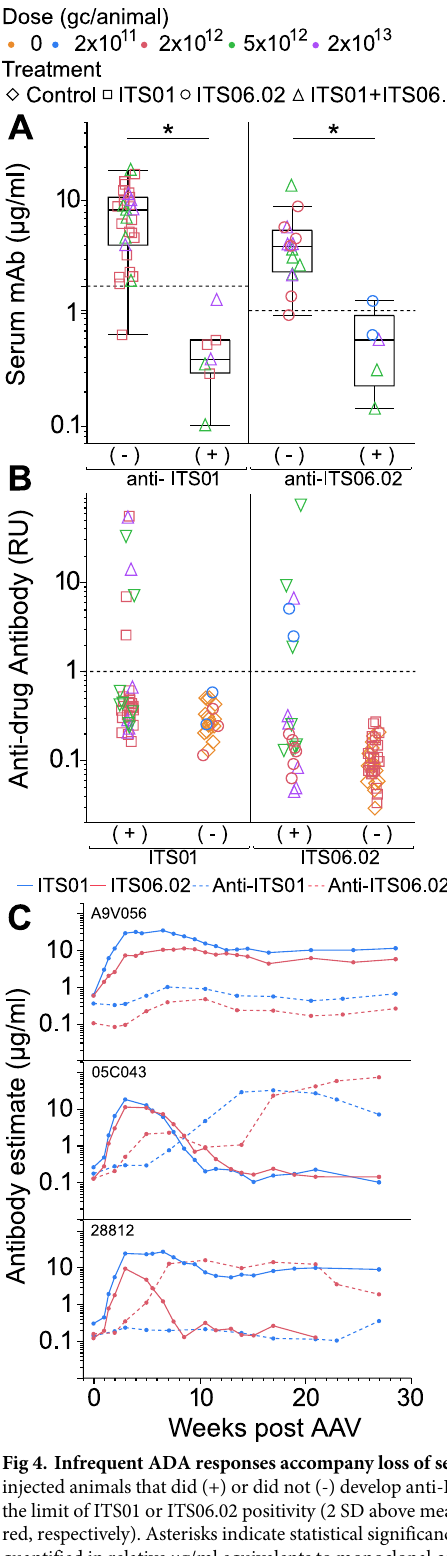
PLOS Pathogens| https://doi.org/10.1371/journal.ppat.1007395 December 5,